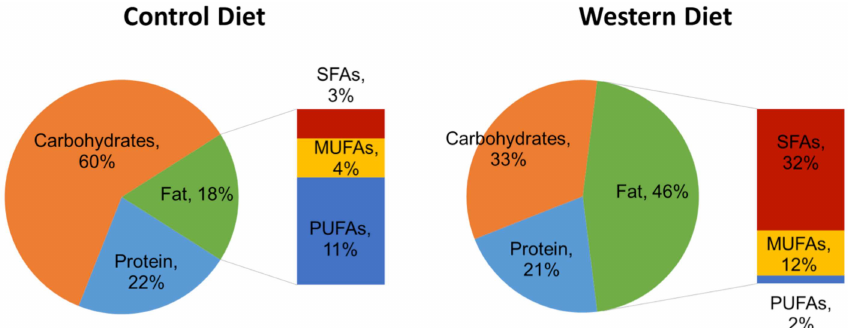
Fig 1. Comparison of guinea pig dietary models by macronutrient composition. Control Diet (feed caloric density = 3.4 kcal/g; left), and Western Diet (feed caloric density = 4.2 kcal/g; right). Macronutrient percentages are by calories. SFA = Saturated fatty acids; MUFA = Monounsaturated fatty acids; PUFA = Polyunsaturated fatty acids.